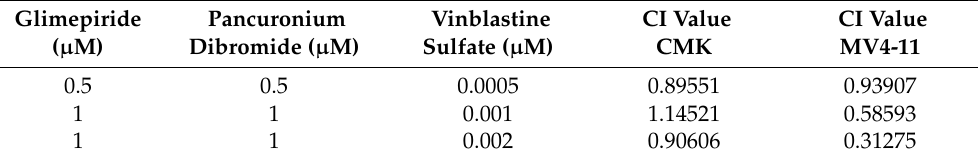
Table 2. Combination index (CI) values calculated using the Chou and Talalay method for the combination of glimepiride (G), pancuronium dibromide (PD) and vinblastine sulfate (VS). Glimepiride Pancuronium ( µ M)